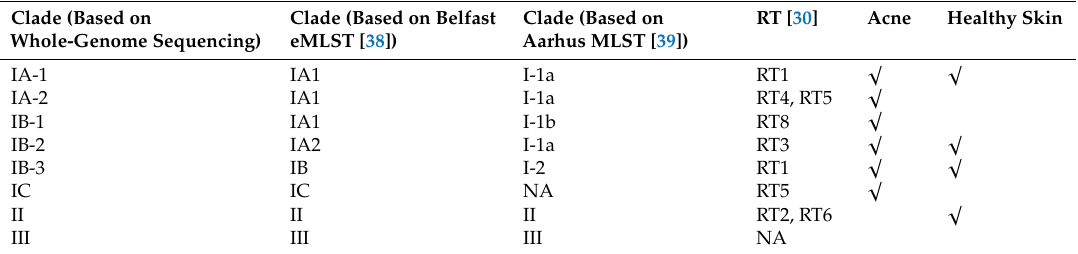
Table 2. Summary of the nomenclatures of C. acnes phylotypes and their association with acne and healthy